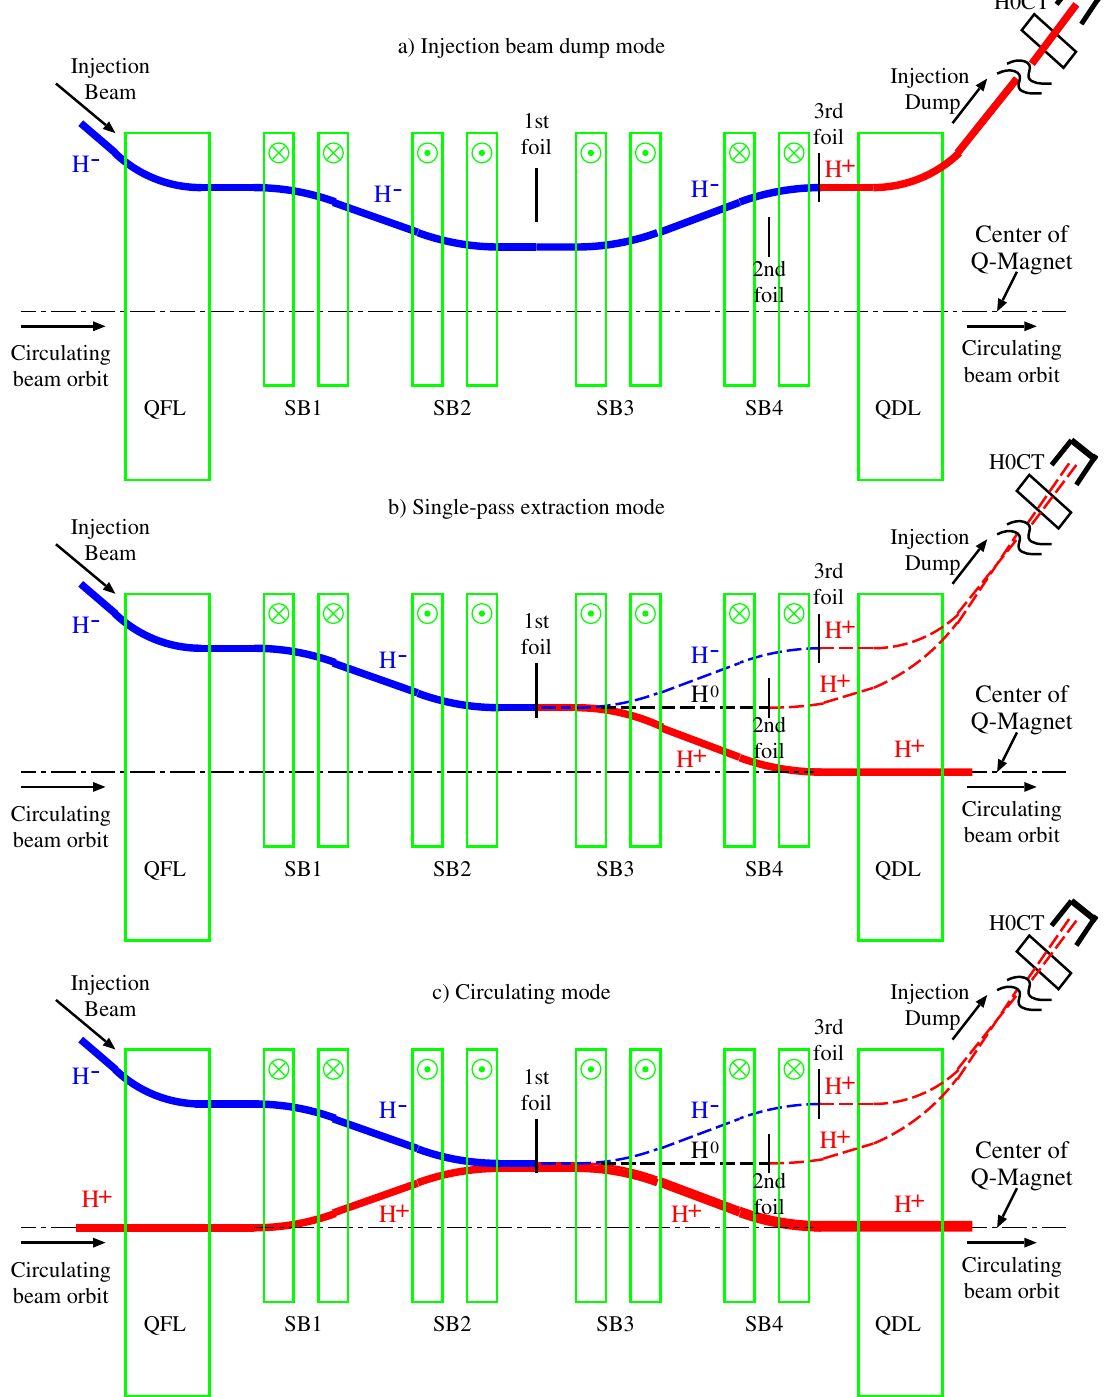
FIG. 3. Roles of the stripper foils and positioning for corresponding operation mode in the RCS. In the injection beam dump mode (a), the primary stripper foil is kept out and thus all the incoming H (cid:1) beam is stripped at the 3rd stripper foil and is transported to the injection beam dump. However, in the other two modes [(b) and (c)] the primary stripper foil is placed at the right position for the beam injection into the RCS ring through stripping most of the incoming H (cid:1) beam to H þ beam. The waste beams then in both cases are mainly the partially stripped H 0 and unstripped H (cid:1) (if any) remaining at the primary stripper foil and through secondary stripping at the 2nd and 3rd foils, respectively, they are transported to the injection beam dump. A ratio of the H0CT signal with any of two later modes [(b) or (c)] to the former mode (a) gives the fraction of the total waste beam measured at the injection beam